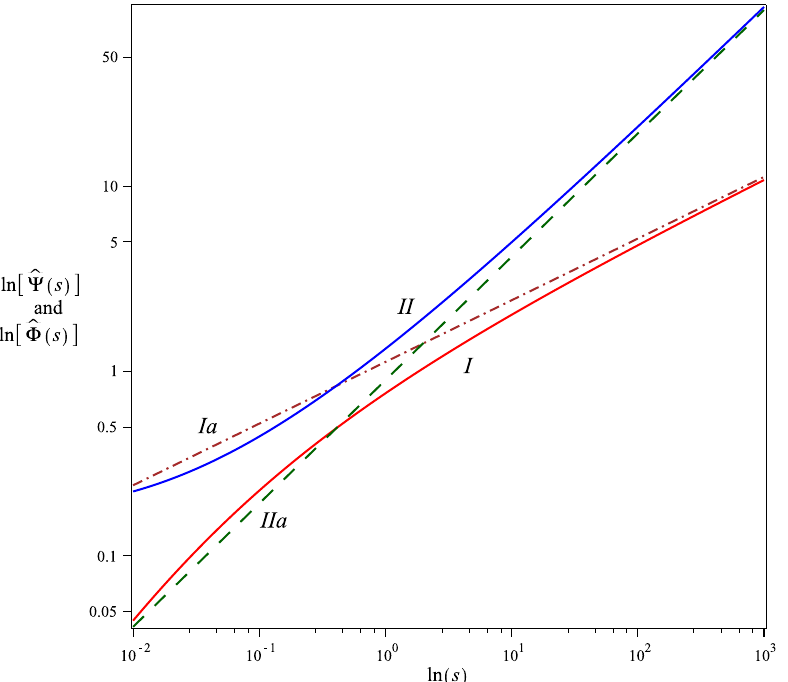
Figure 1. Plot presents the comparison between characteristic functions (cid:98) Ψ KWW ( s ) (red solid curve no. I ) and (cid:98) Ψ CC ( s ) (brown dot-dashed curve no. Ia ), as well as between partner functions (cid:98) Φ KWW ( s ) (blue solid curve no. II ) and (cid:98) Φ CC ( s ) (green dashed curve no. IIa ) for α = 1/3 and τ = 1. The characteristic exponents (cid:98) Ψ KWW ( s ) and (cid:98) Φ KWW ( s ) have been calculated using Equation (8) whereas (cid:98) Ψ CC ( s ) and (cid:98) Φ CC ( s ) are given by Equation (14). The latter ones are, respectively, multiplied and divided by [ Γ ( 4/3 )] − 1